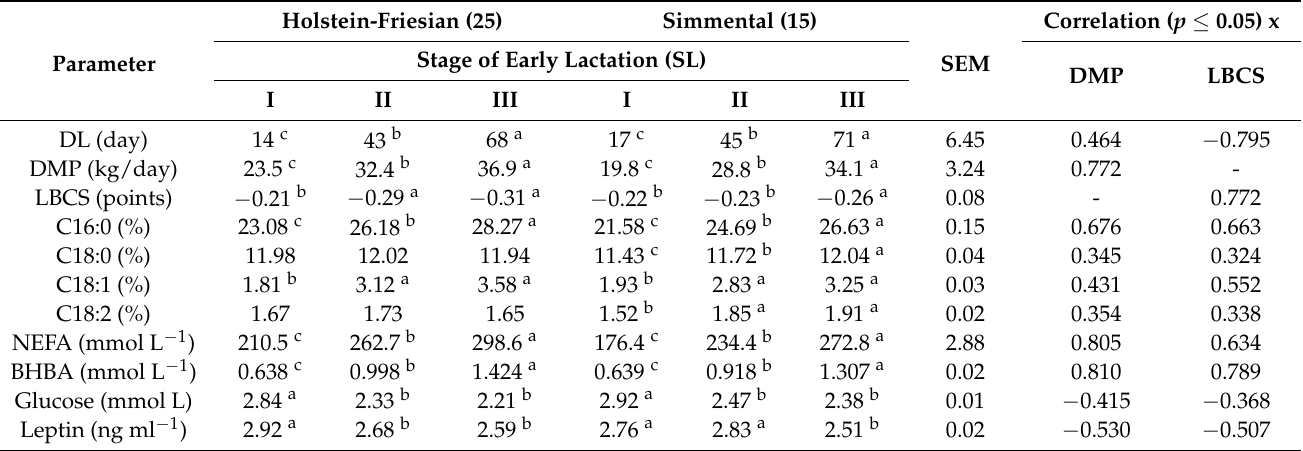
Table 1. Changes in daily milk production (DMP), loss of body condition (LBCS), NEB biomarkers and correlations with DMP and LBCS in early lactation (3 stages).